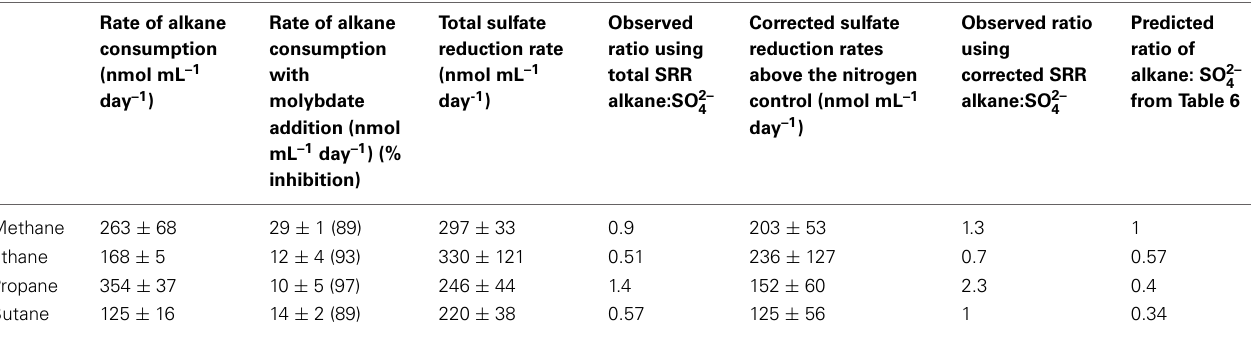
Rates of alkane consumption were calculated using all available time points based on a linear regression. Rates of sulfate reduction calculated as described in the